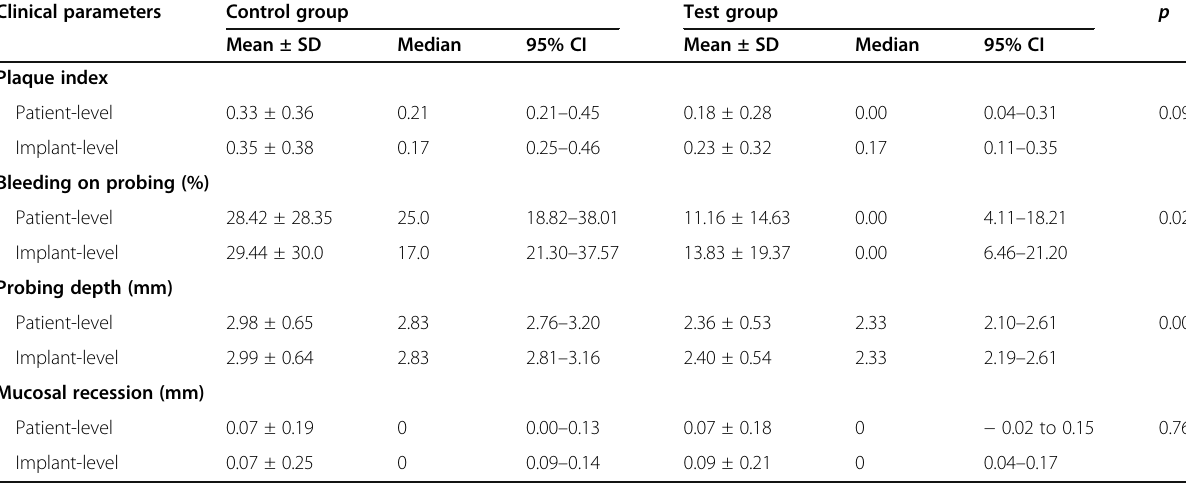
Table 2 Clinical parameters (mean ± SD, median and 95% CI) Clinical parameters